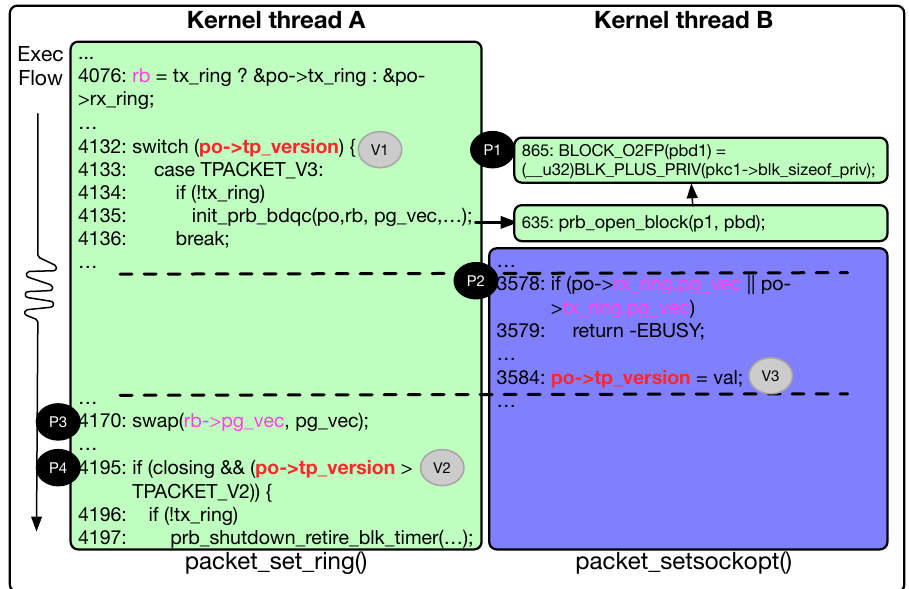
Figure 4. Checkpoint of CVE-2016-8655 . P1 and V3 are the two checkpoints.